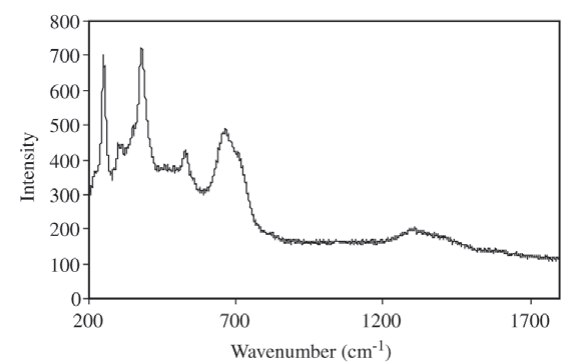
Figure 3. Raman spectrum of a carbon steel specimen, exposed for two months at Cubatão site, showing characteristic peaks of magnetite, goethite and lepidocrocite from black oxide region.